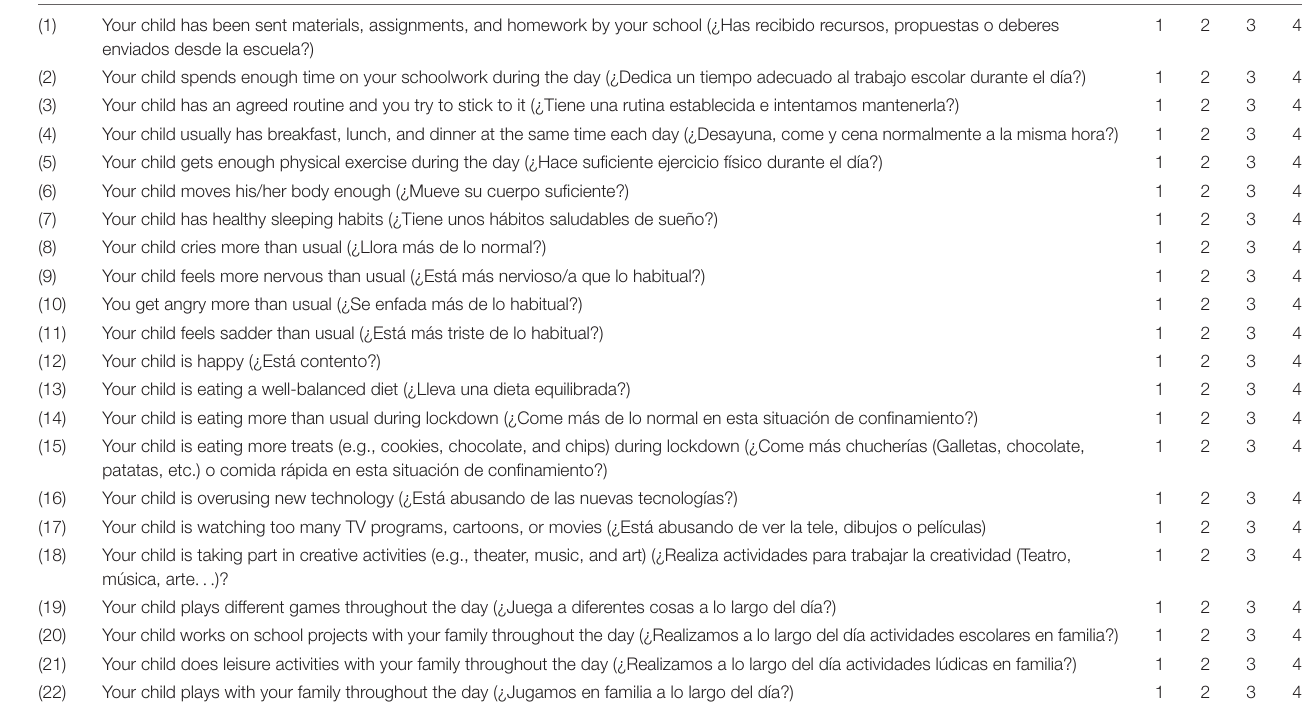
TABLE 1 | Survey on the well-being of children in lockdown.